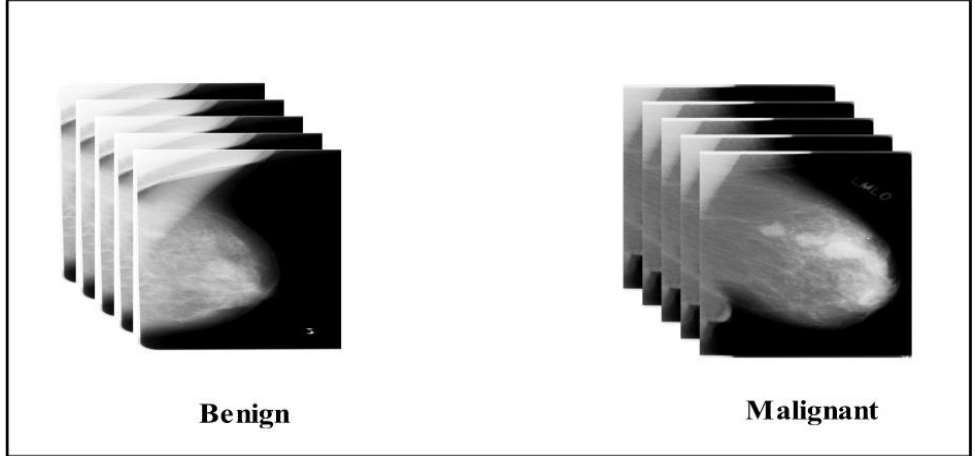
Figure 2. Sample images CBIS-DDSM.